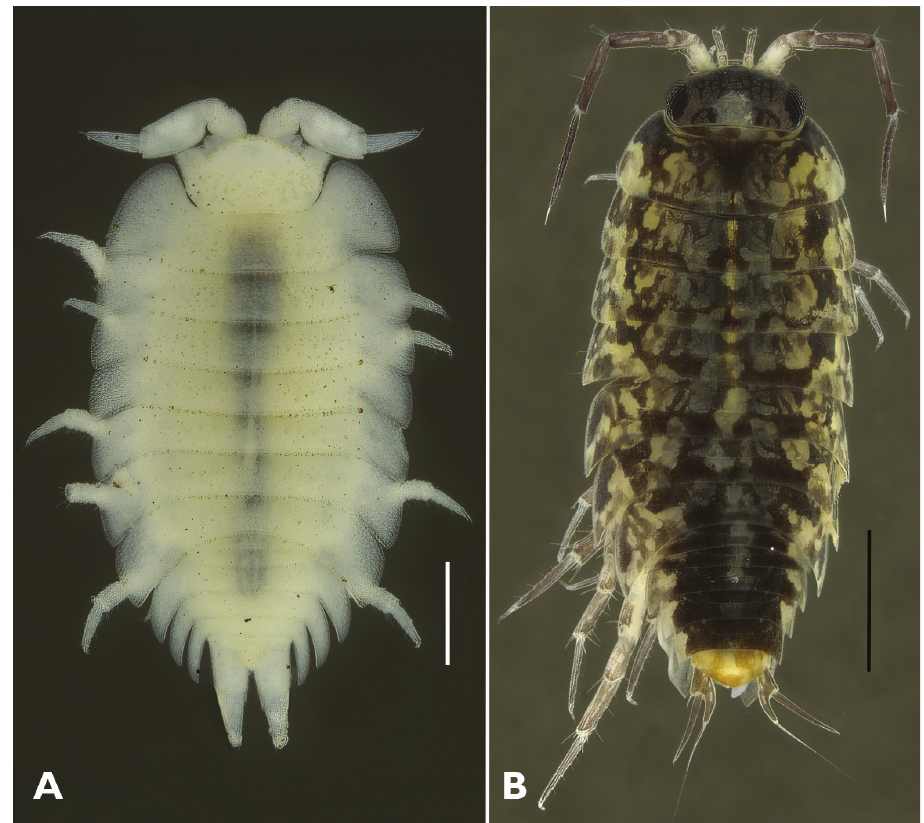
Figure 4. Habitus of Estonian Oniscidea species A Platyarthrus hoffmannseggii B Ligidium hypnorum . Scale bars: 0.5 mm ( A ); 1 mm ( B